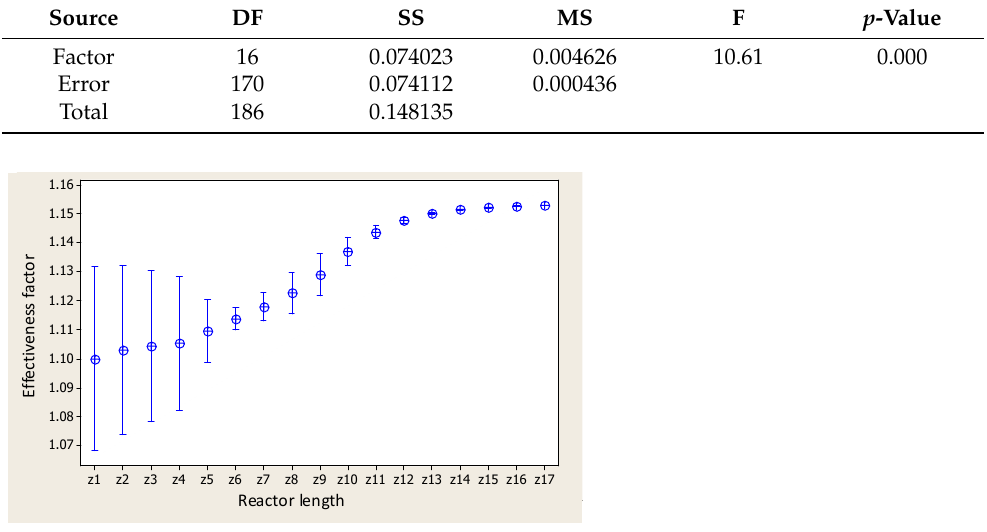
Figure 6. Analysis of variance of the effectiveness factor vs. length reactor (obtained from Table A4). Interval plot 95% CI for the mean. Interval plot 95% CI for the Table 3. Analysis of variance of the effectiveness factor versus the length reactor.